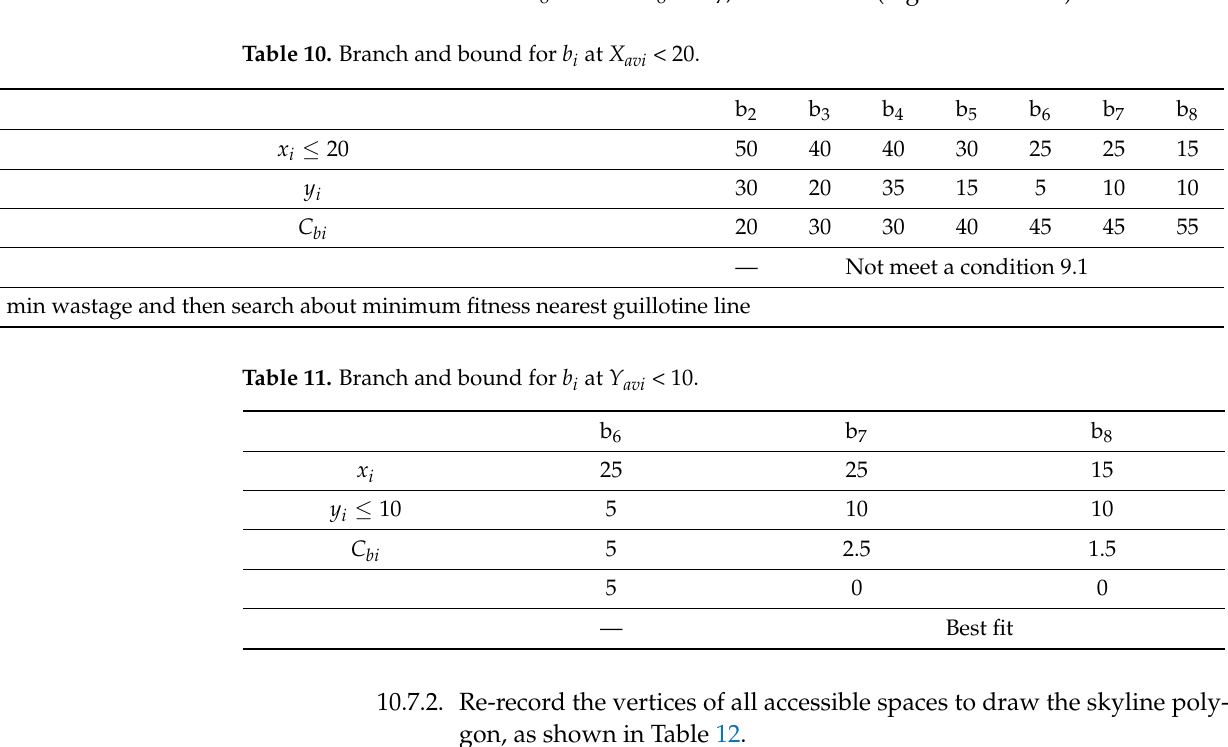
Table 10. Branch and bound for bi at X avi < 20.